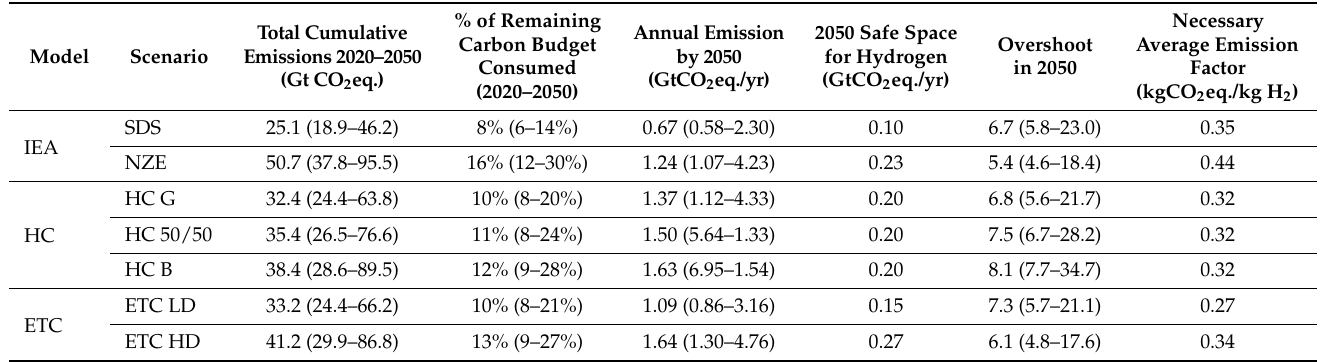
Table 3. 2050 implications of the hydrogen economy per model and